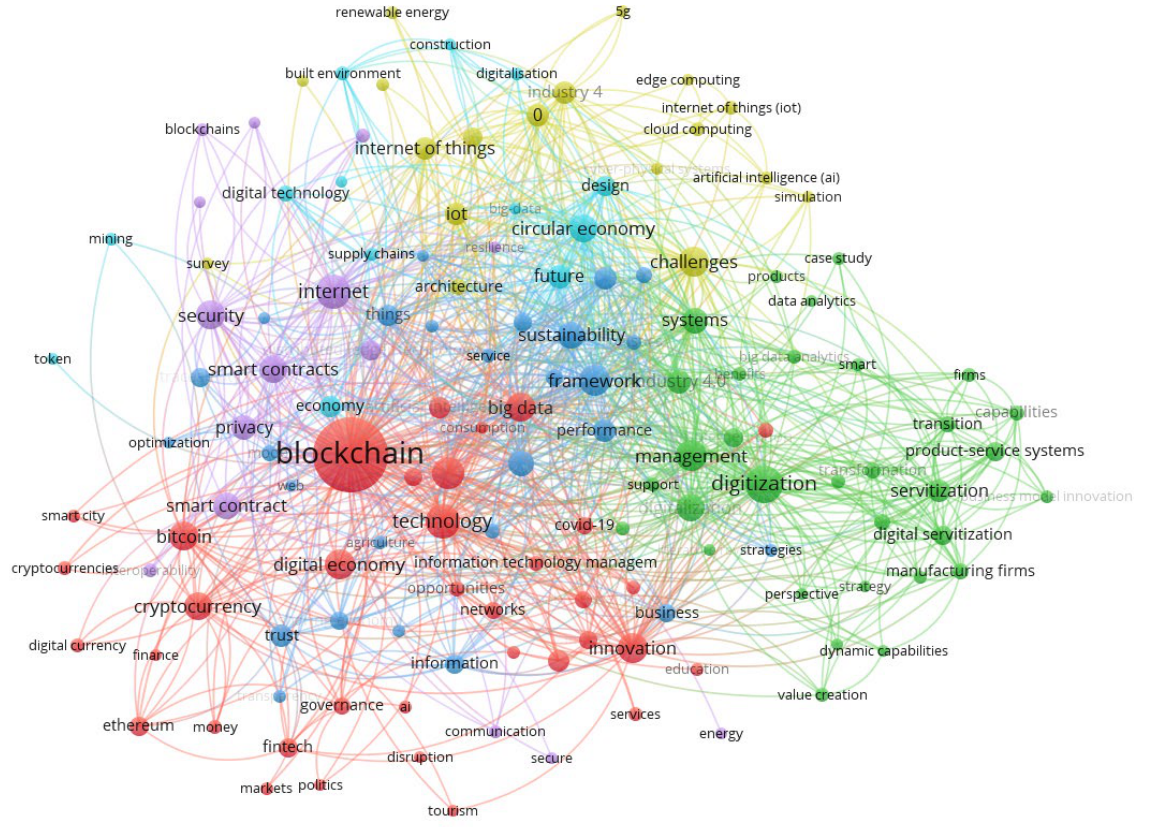
Figure 4. Keywords co-occurrence network visualization of PSSs and BC in the context of digitization and digital economy (generated by authors).